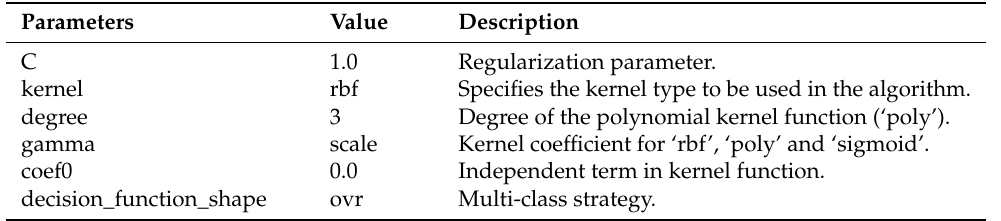
Table 7. SVM (OVA) parameters from scikit-learn library.